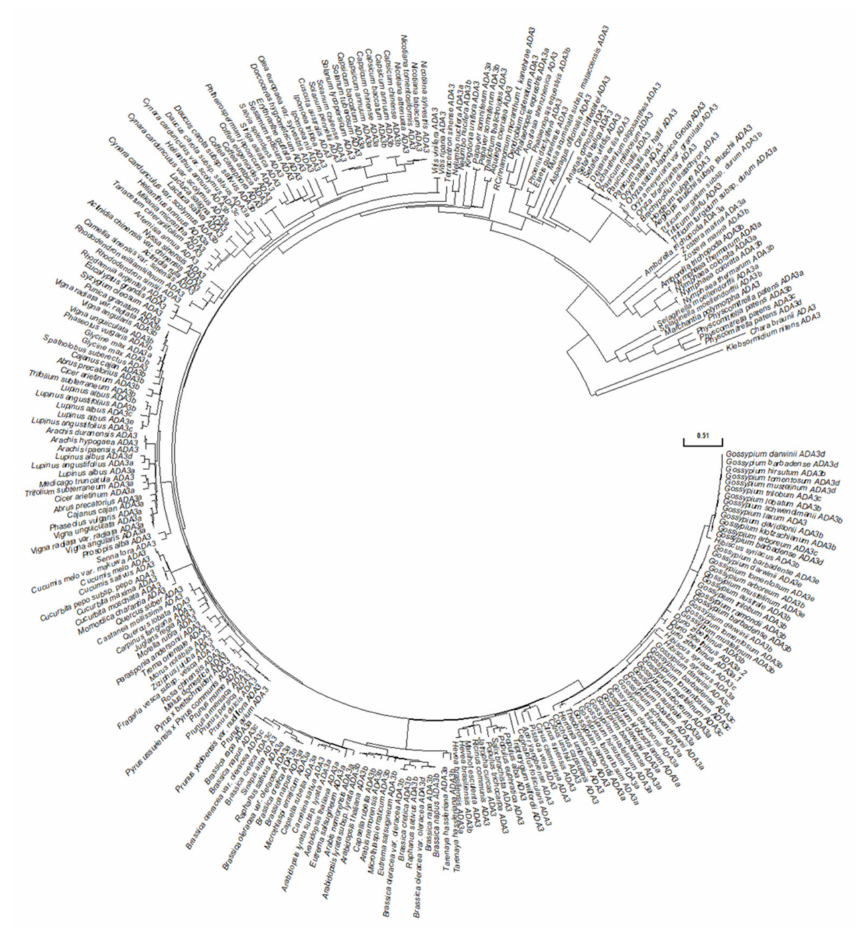
Figure 2. Phylogenetic analysis of ADA3 proteins in